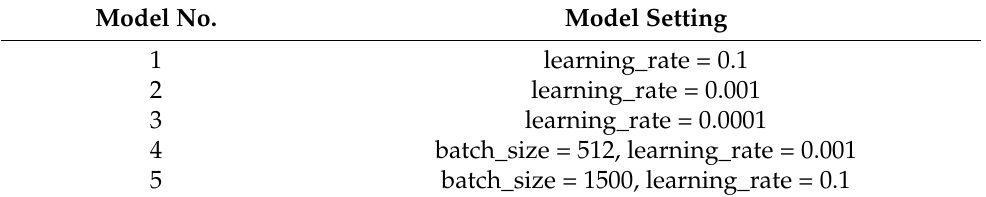
Table 4. Parameter comparative experiment.